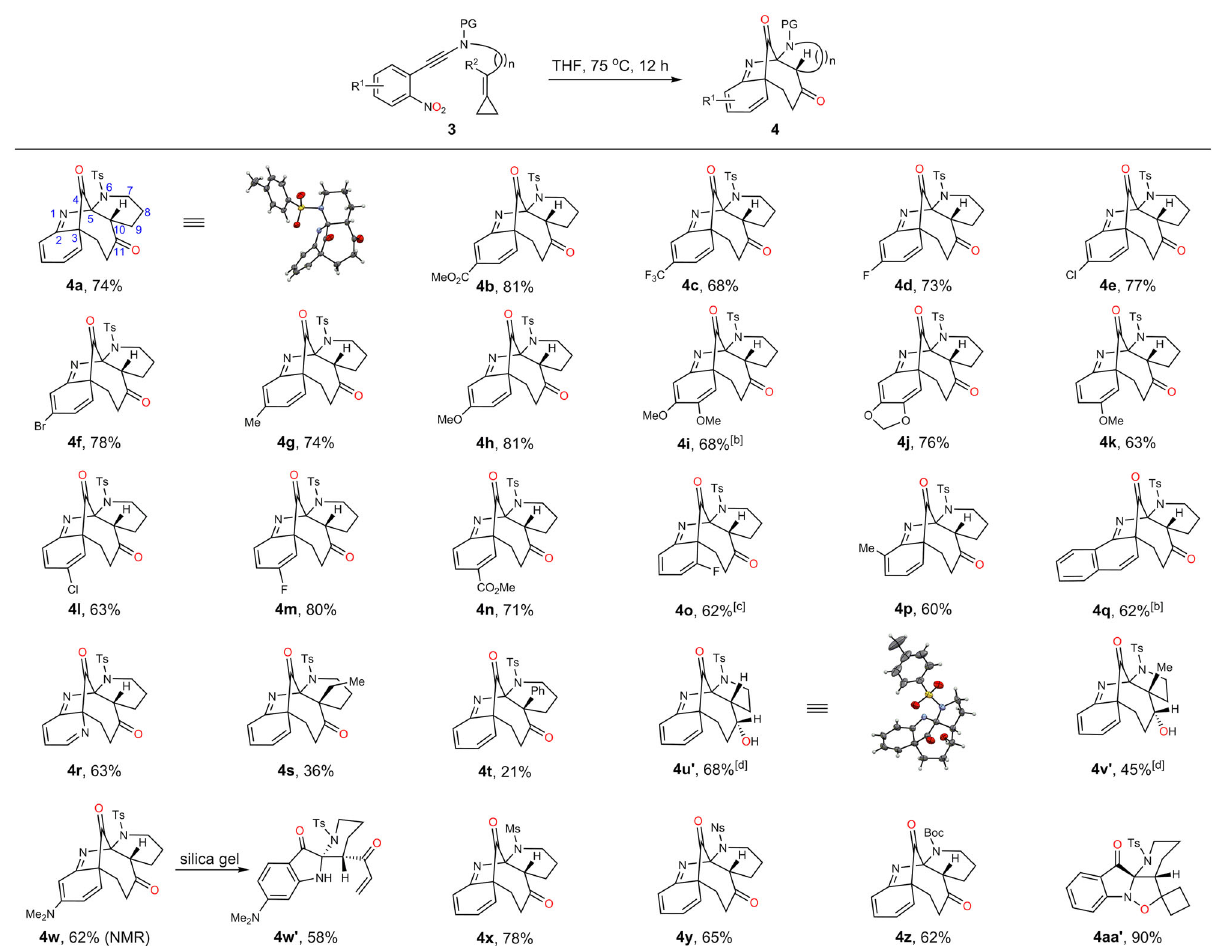
Fig. 5 | Evaluation of scope of benzazepines a . a Reaction conditions: The solution of 3 inTHF(0.03M)wasstirredunderN 2 atmosphereat75 o Cfor12h; b Heatingthe resulting fi ltrate of 3 after the ynamide formation; c 80°C for 36h; d NaBH 4 (3 eq) and0.5mLMeOHwereaddedwhentherearrangementreactionmixturecoolingto room temperature, then stirred for another 1h. Note: these imine-containing